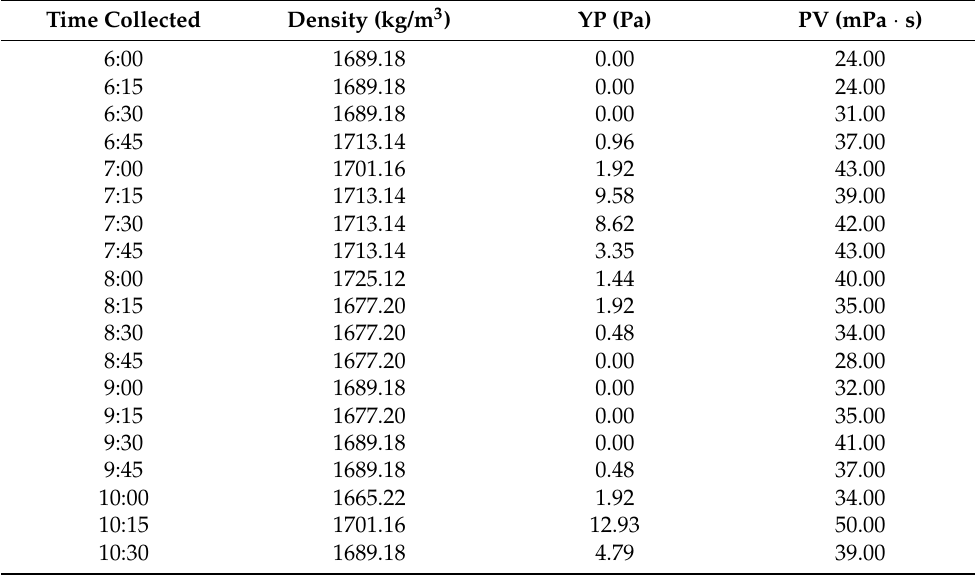
Table 1. Room temperature properties of drilling fluid during test.